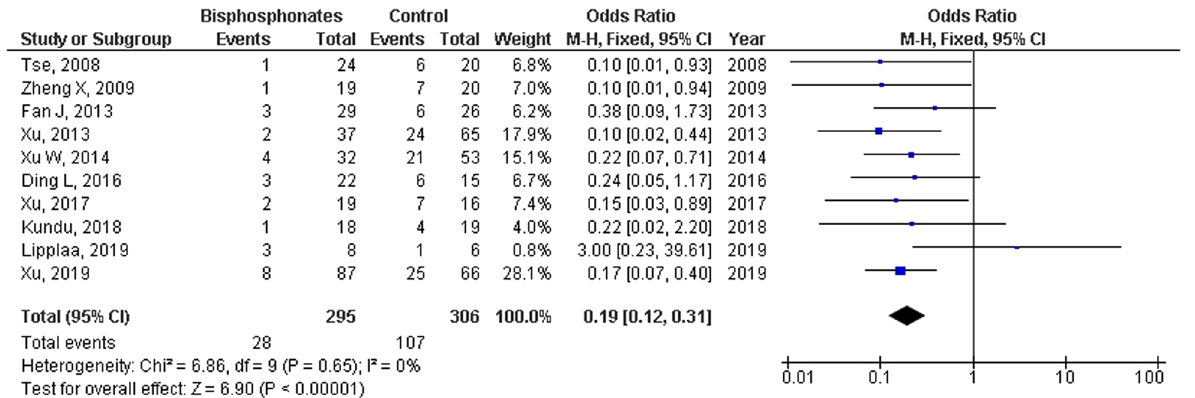
Fig. 2 The forest plot showing the influence of bisphosphonates in comparison to controls on postoperative recurrence outcomes in patients with giant cell tumors of the bone in all stages